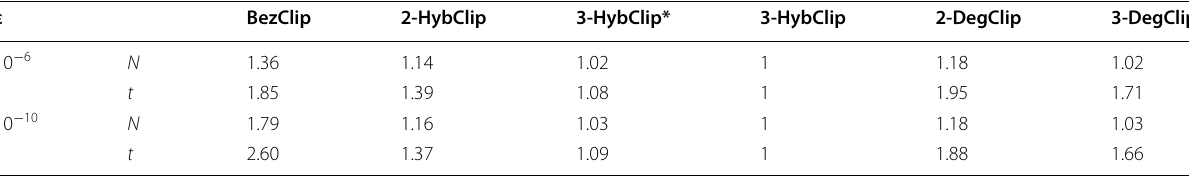
Table 3 Relative computing iterations N and computing time t ε BezClip 2-HybClip